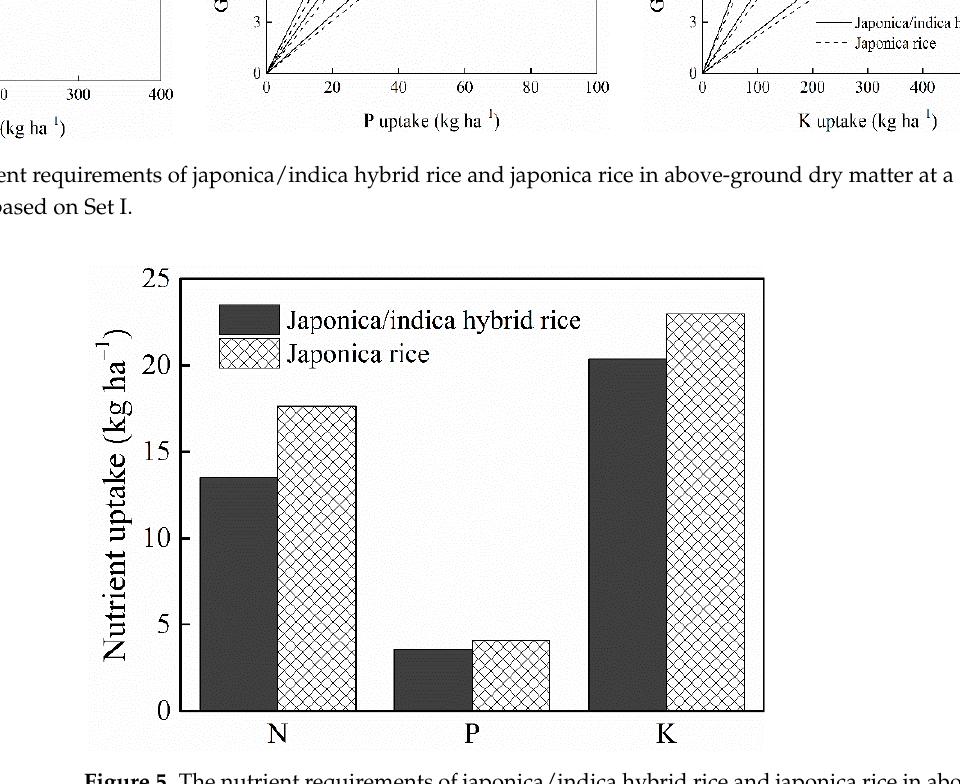
Figure 6. Relationship between grain yield and nutrient uptake in total above-ground plant dry matter under different yield potentials simulated by the QUEFTS model for japonica/indica hybrid rice ( a – c ) and japonica rice ( d – f ). YD, YU, and YA represent the maximum dilution, balanced uptake of nutrient in plant dry matter, and maximum accumulation, re- spectively. The yield potential ranged from 9 to 15 t ha − 1 .